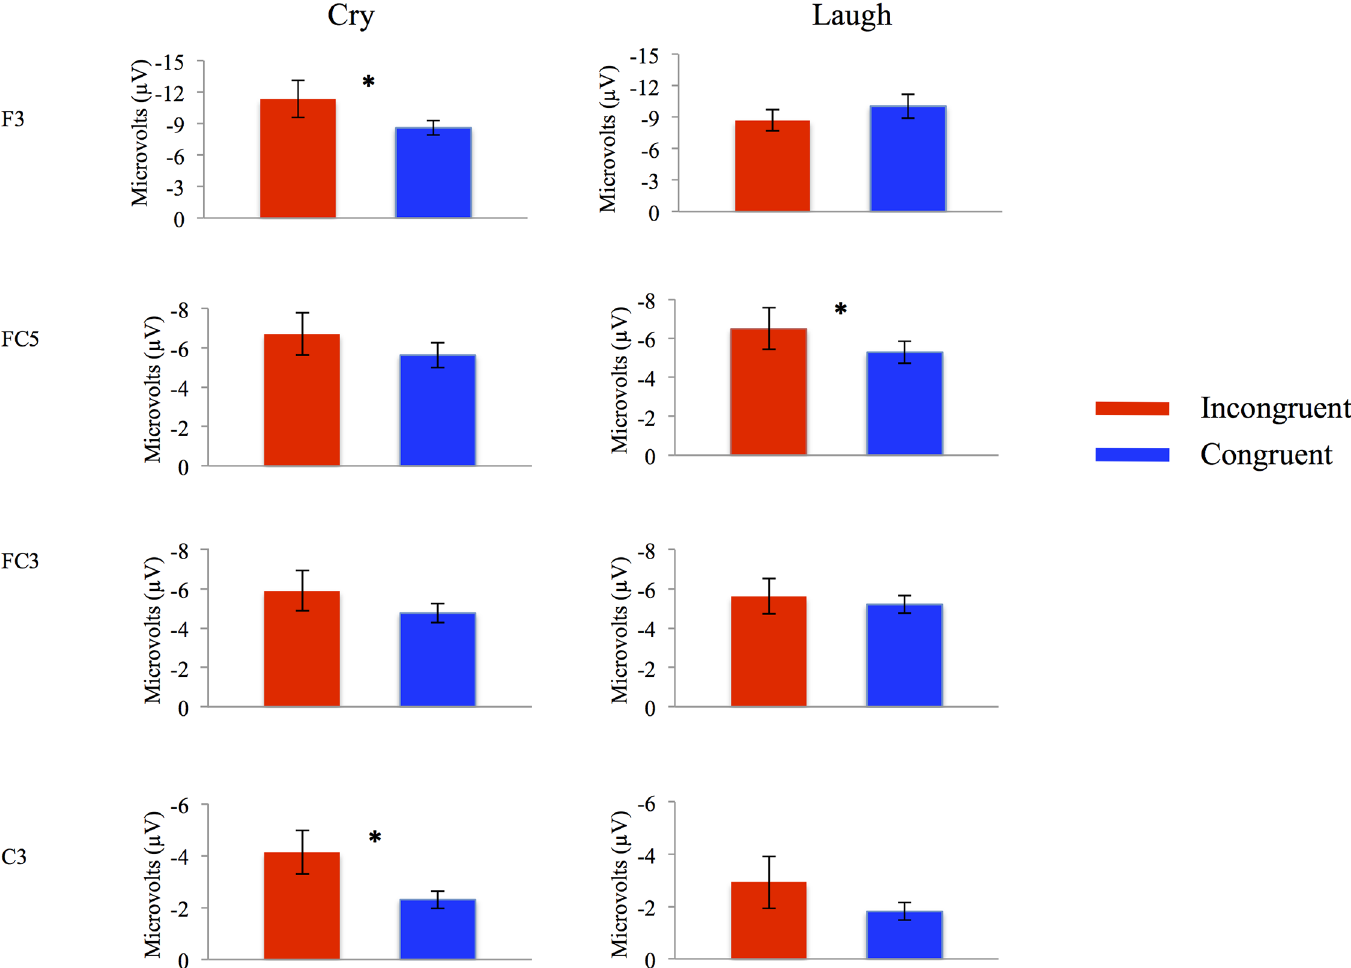
Fig 4. The Stroop effect on the N450 ERP occurred in the frontal and central locations after infant cries and in the frontal-central location after infant laughs. Mean amplitudes (in microvolts) of the N450 ERP by incongruent (red bars) and congruent trials (blue bars) for electrodes in the left frontal (F3), the left frontal-central (FC5/FC3), and the left central locations (C3). Cry and laugh blocks are presented in the left and right columns, respectively. The asterisks ( * ) denote statistical significance values at p < .01. Error bars represent the standard errors around the mean.